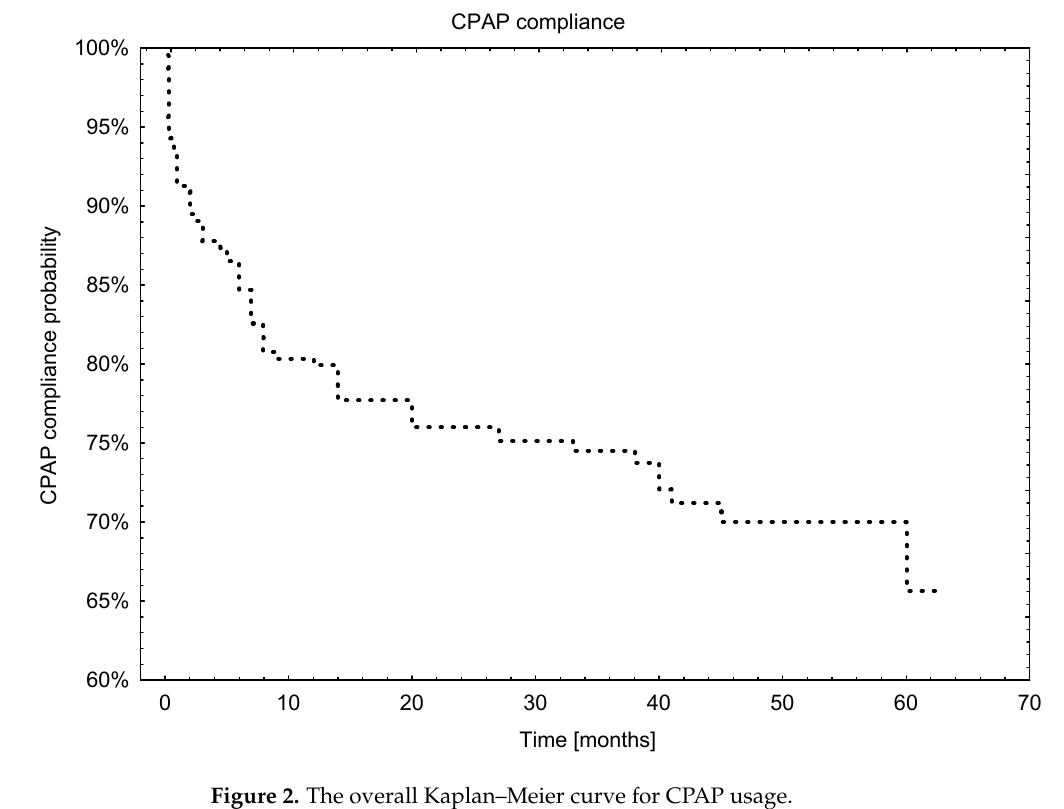
Sex or the presence of positional OSA did not influence CPAP compliance, p = 0.85 and p = 0.48, respectively. Otherwise, at AHI cut-off of 15 (mild vs. moderate or severe disease) compliance was worse for patients with AHI below this threshold (43.2%) vs. those with AHI ≥ 15 (67.9%), p = 0.003. For patients with AHI < 15 the drop in compliance was 40% in less than 10 months vs. 15% for the group with AHI ≥ 15, Figure 3. Figure 2. The overall Kaplan–Meier curve for CPAP usage. Figure 2. The overall Kaplan–Meier curve for CPAP usage.